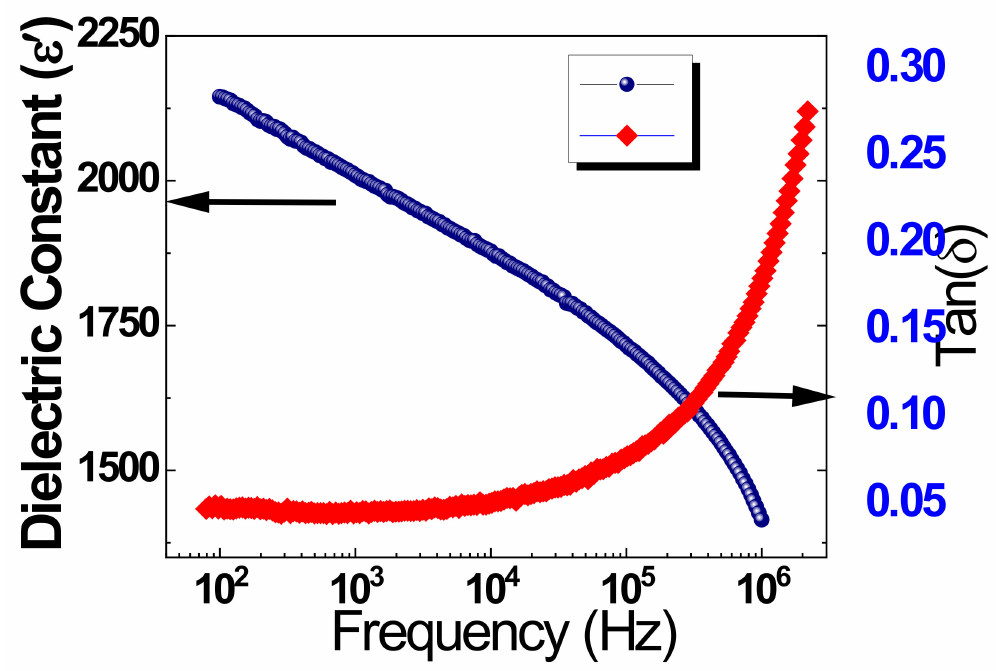
Figure 5. Room temperature dielectric properties (dielectric constant and dielectric loss-tan δ ) of (BTO/NFO/BTO) tri- layered thin film on substrate Pt/Ti/SiO 2